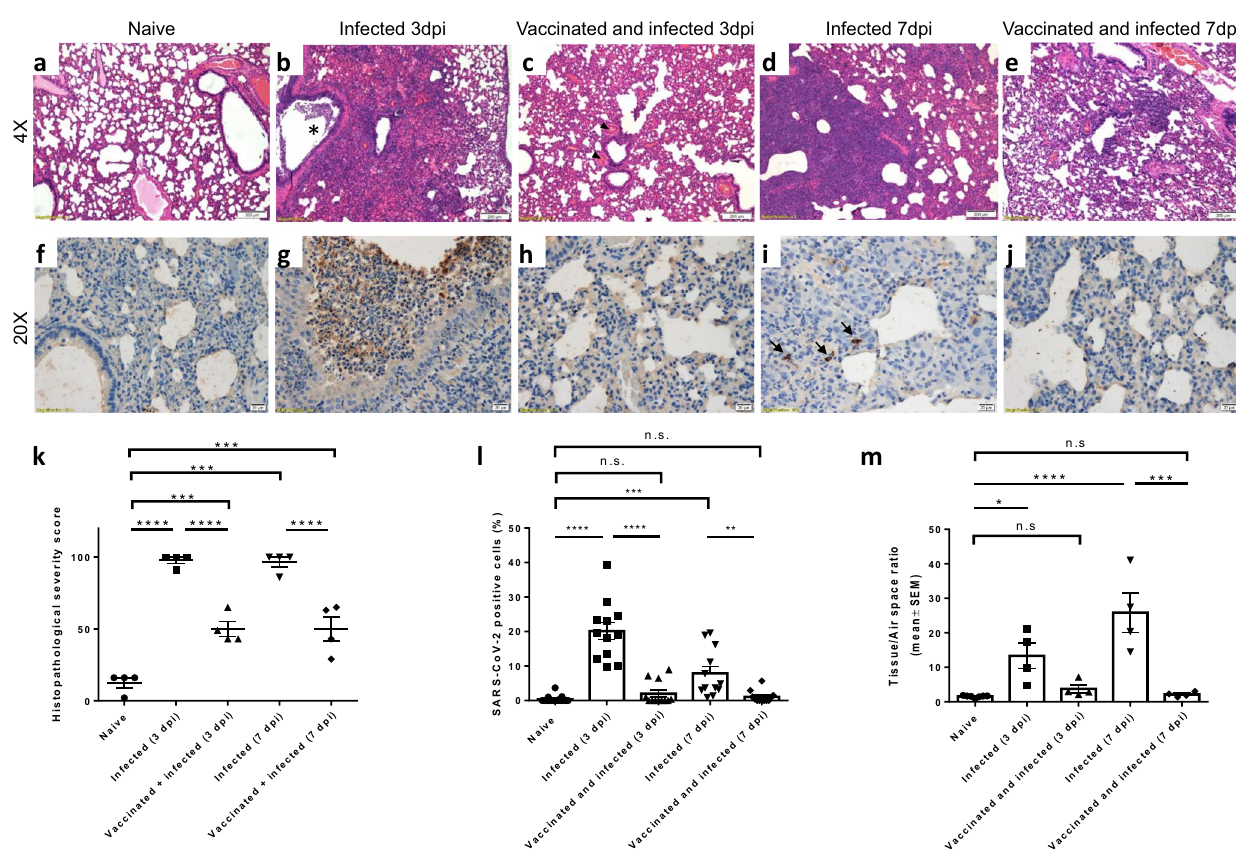
Fig. 7 Histopathological analysis of rVSV- Δ G-spike i.m. vaccinated and infected hamsters ’ lungs at 3 and 7 dpi. General histology (H&E) and SARS- CoV-2 DAB immunolabeling of naive, unvaccinated infected (5 × 10 6 ), and vaccinated (10 6 pfu) hamsters ’ lungs, at 3 and 7 dpi. Lungs were isolated and processed for paraf fi n embedding from naive ( a , f ), infected (5 × 10 6 pfu) ( b , g for 3 dpi and d , i for 7 dpi) and vaccinated and infected ( c , h for 3 dpi and e , j for 7 dpi). Sections (4 µ m) were taken for H&E staining ( a – e ) and SARS-CoV-2 DAB immunolabeling ( f – j , positive SARS-CoV-2 — brown, hematoxylin counterstaining — blue). An asterisk (*) indicates cellular debris in bronchiolar lumen. Black arrow heads indicate congestion of blood in blood vessels. Black arrows indicate positive stained cells. a – e : scale bar = 200 µ m; f – j : scale bar = 20 µ m. k Histopathological severity analysis of hamsters lungs of naive, vaccinated, and infected lungs, at 3 and 7 dpi. l Digital morphometric analysis of DAB immunohistochemical staining for SARS-CoV-2 in lungs of naive, infected, and vaccinated lungs, at 3 and 7 dpi. m Tissue/air space analysis of naive, infected, and vaccinated lungs, at 3 and 7 dpi. Data for a – j was taken for fi ve groups. Each group includes four animals. For each animal, fi ve fi elds were imaged and analyzed. Data for k – m are presented as mean values ± SEM. Statistical analyses for k – m were performed by one-way ANOVA with Tukey ’ s multiple comparisons test, with p < 0.0001, p = 0.0006, p <